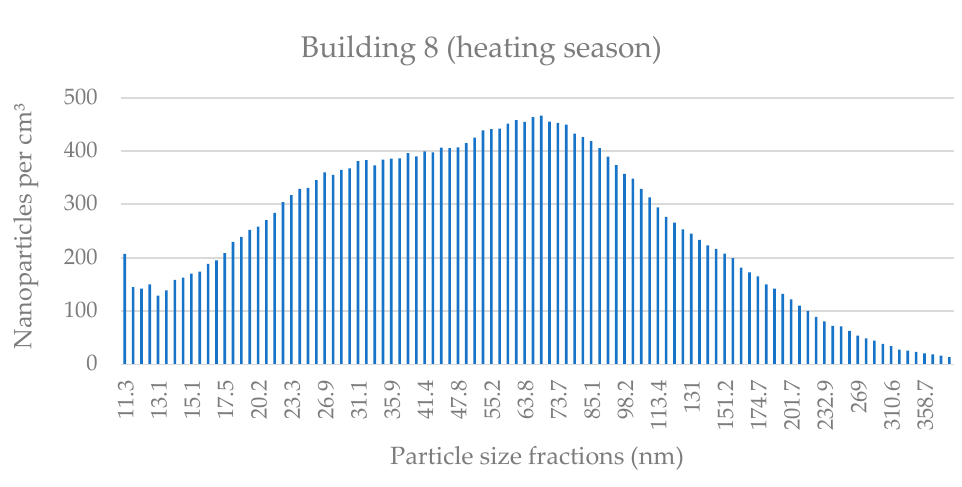
Figure A15. The average nanoparticle concentration in each size fraction in Building 8 during a one-week measurement period during the heating season.